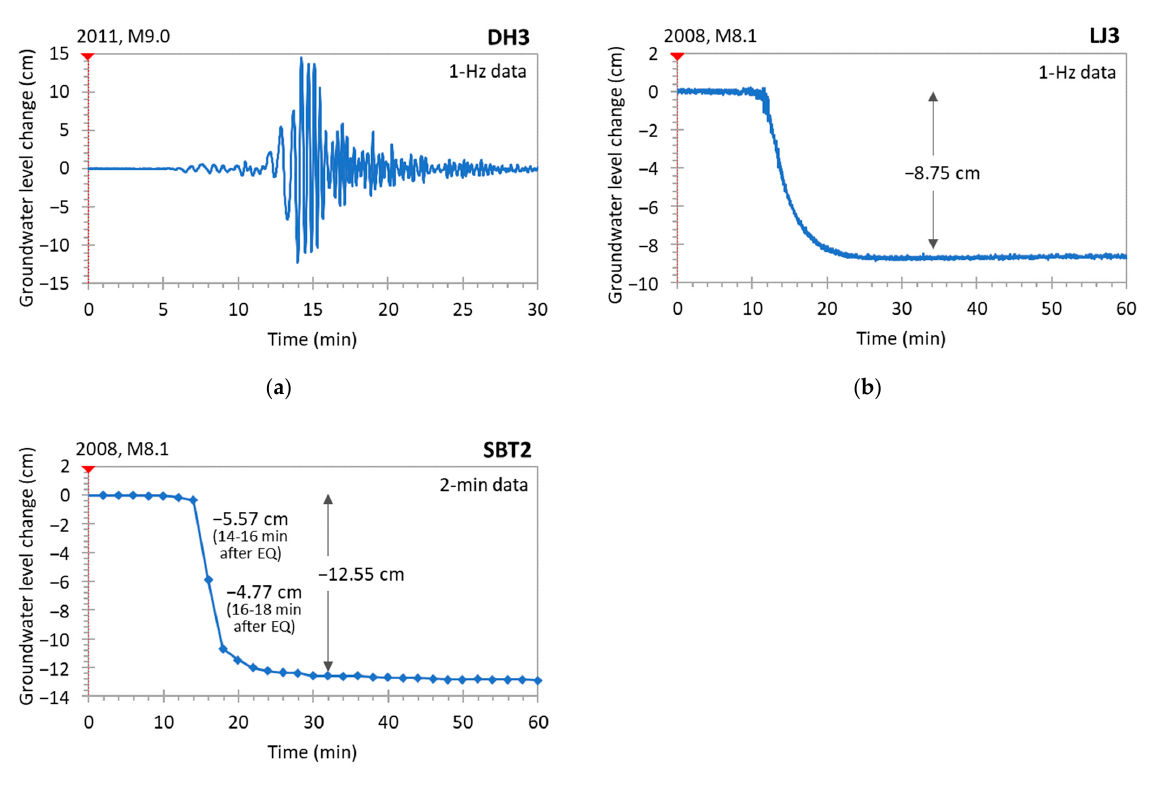
Figure 4. Changes in groundwater level due to large, distant earthquakes: (a) oscillatory changes in well DH3, recorded in 1 Hz frequency, following the 2011 M9.0 Tohoku-oki earthquake of the shore of east Japan; ( b ) sustained changes in well LJ3, recorded in 1 Hz frequency, following the 2008 M8.1 Wenchuan earthquake; ( c ) sustained changes in well SBT3, recorded every 2 min, following the 2008 M8.1 Wenchuan earthquake.